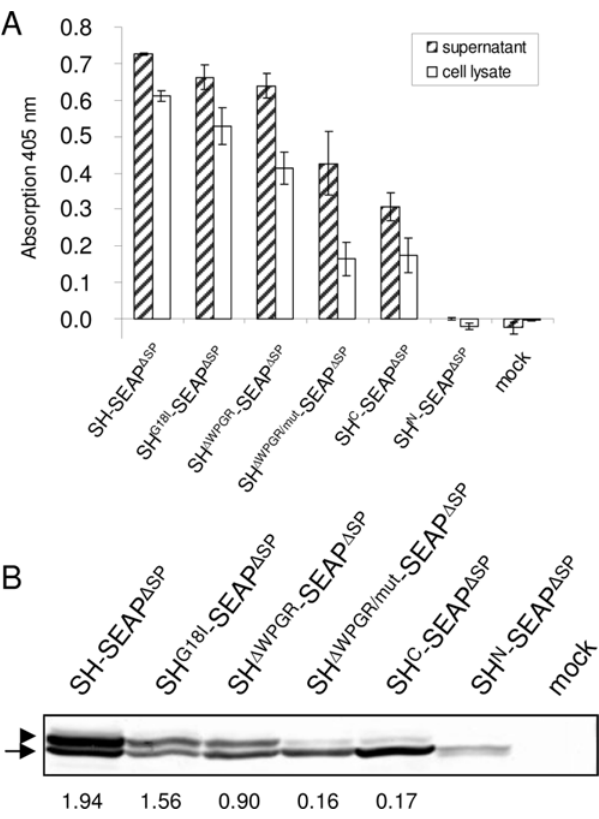
Figure 5. Mutation of the transition area impairs secretory activity of SEAP fusion proteins. (A) SEAP activity was measured in the supernatant (hatched bars) and whole cell lysate (white bars) of transfected HEK 293T cells after 5 min substrate incubation. Cells transfected with the empty vector were used as negative control (mock). Error bars show s.e.m. ( N =4). The data for cells with constructs Figure 2A. (B) Western blots were prepared from whole cell lysates of transfected HEK 293T cells, and SEAP fusion proteins were detected with anti-myc antibody. The upper bands of the fusion proteins, except of that from SH N -SEAP D SP , represent the N-glycosylated and N- terminally processed protein population ( c ), the lower band the non processed population (arrow). The values below the lanes show the density ratio of the upper band to the lower band for each fusion protein which decreases the more the transition area is